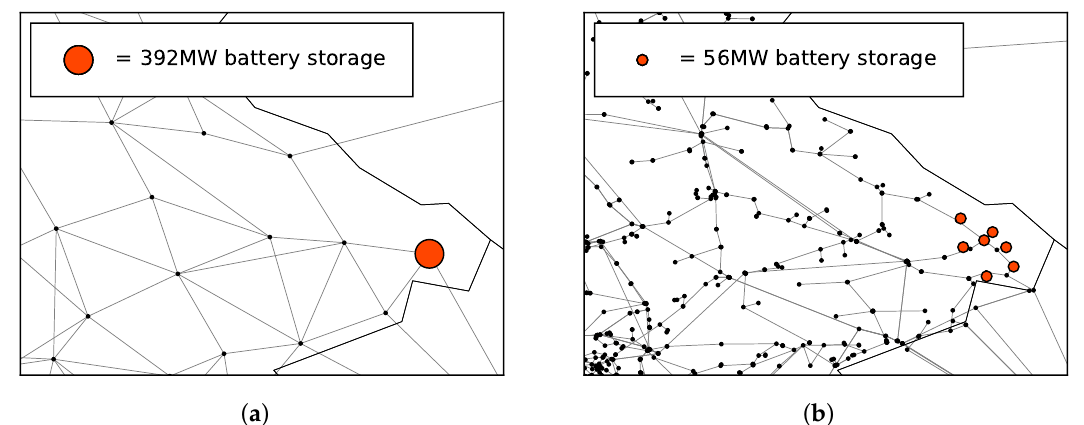
Figure 4. Exemplary allocation of battery storage expansion before ( a ) and after ( b ) disaggregation. In ( a ) the EHV and HV grid is reduced to 300 buses. In ( b ) the original complete complexity is displayed. For better visualization it was zoomed in to a subregion of southern Bavaria next to the border to the Czech Republic and Austria. The basic grid topology is visualized by grey lines and black